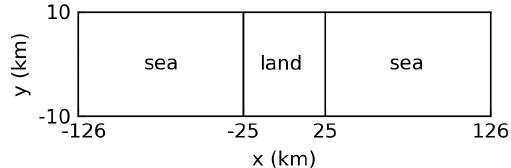
Figure 3. Domain